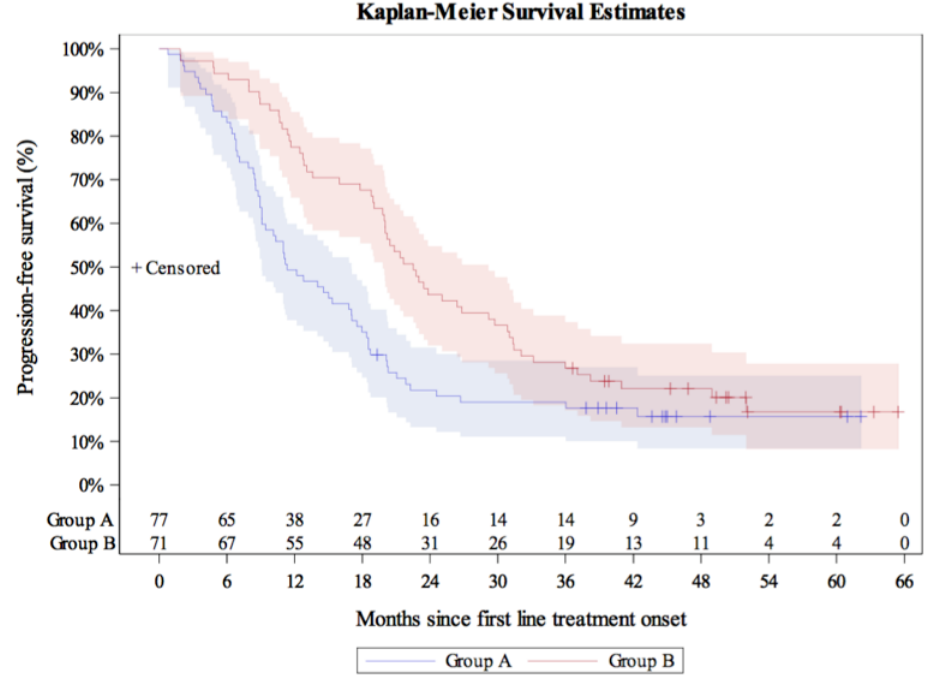
Figure 3. Kaplan-Meier progression-free survival curves in the subgroups of patients who had received first-line platinum-based CT alone (Group A) and platinum-based CT plus angiogenesis inhibitor (Group B).